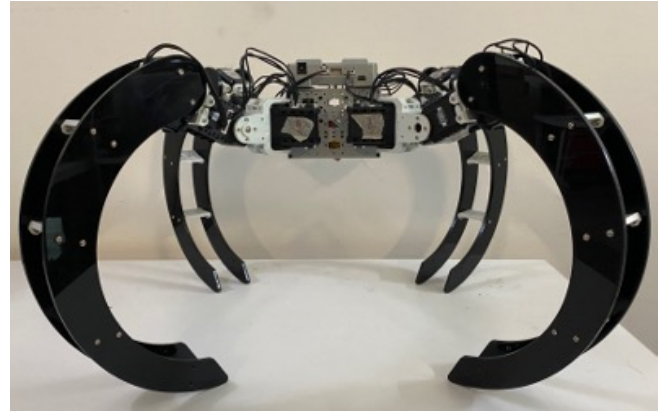
Figure 4. Crawling